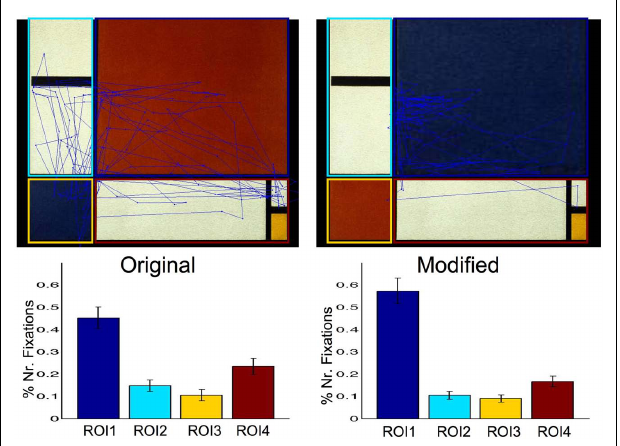
FIGURE 3 | Original (left) and modified version (right) of Mondrian’s “Composition No. 8,” with the fixations of a subject superimposed. In the original version the subject explored most of the canvas and in the modified version, the gaze is attracted to the bottom right corner.The color rectangles show three regions of interest (ROI1 in blue, ROI2 in green, and ROI3 in red).The relative average number of fixations for all subjects are shown in the bottom plots.There were a larger number of fixations to ROI3 for the modified